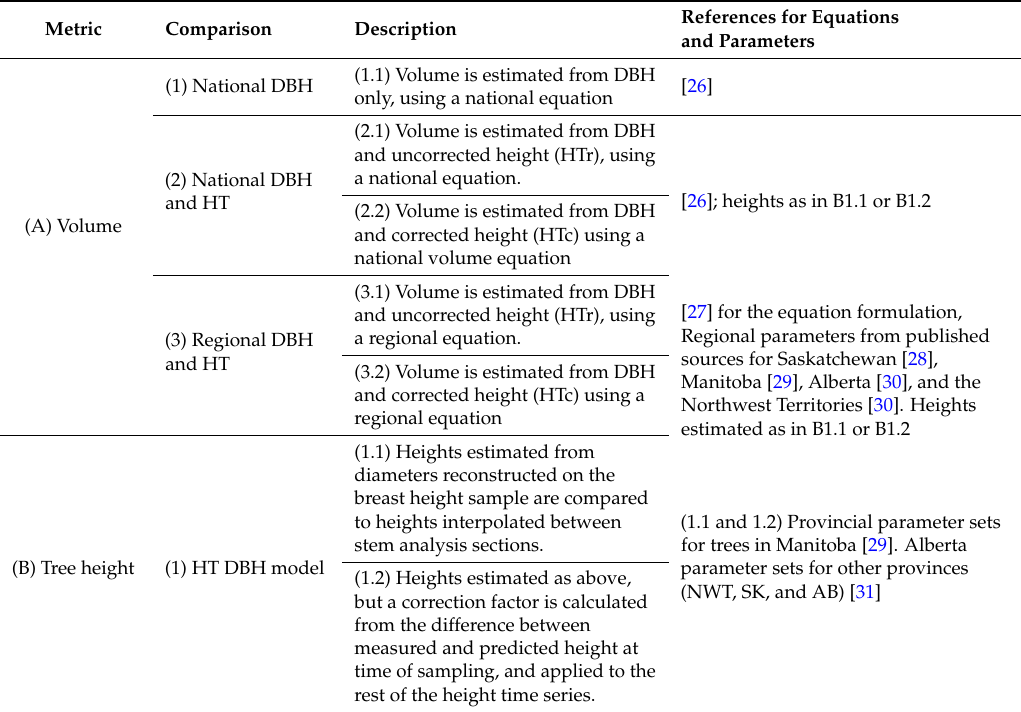
Table 2. Summary of the volume and height estimation methodologies used in the